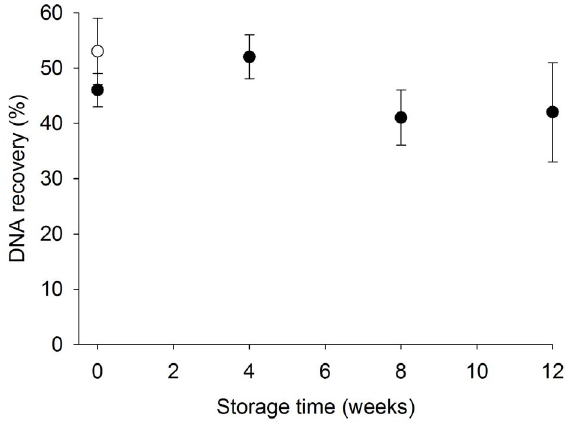
Figure 4. There is no significant difference in DNA recovery using the lyophilized urine collection pipette stored for 0, 4, 8, or 12 weeks (black circles) compared to freshly prepared adsorption reagents (white circle) (mean 6 s.d., n=3,).